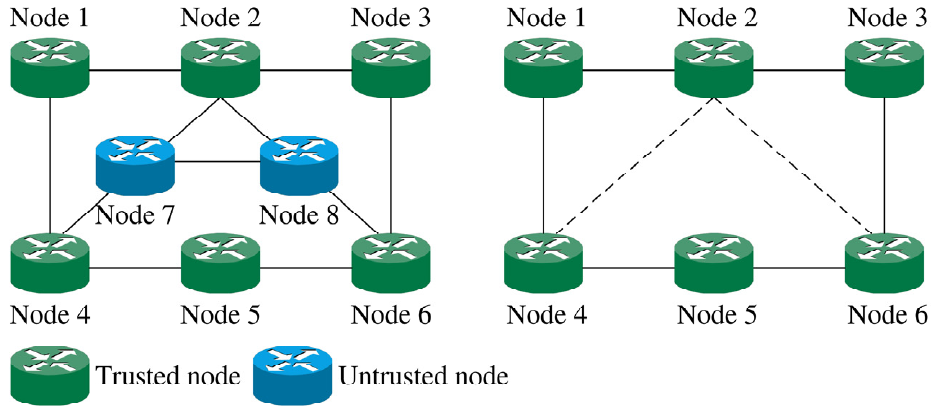
Figure 3. Process of network topology abstraction. Table 3. The operation of the services in the TAPS-PTR.